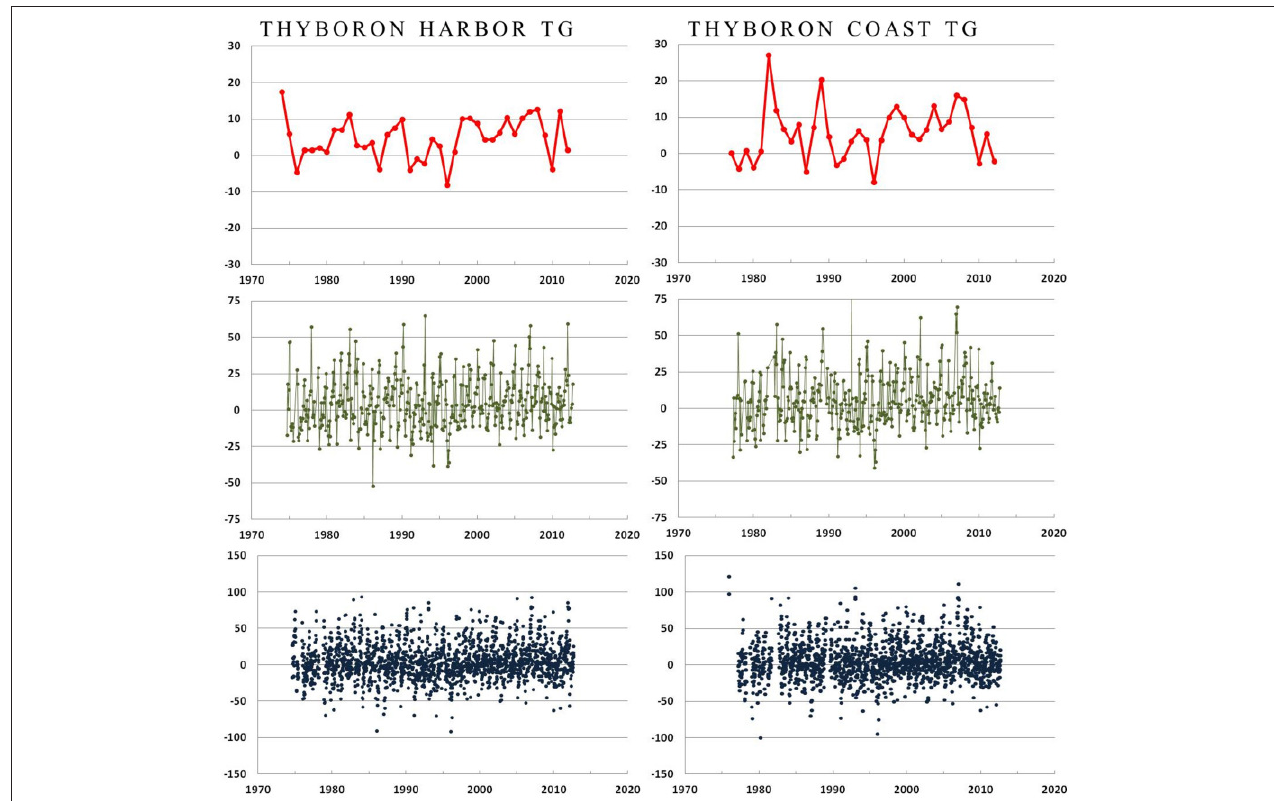
FIGURE 5 | Yearly, monthly, and weekly means (top to bottom) water levels (in cm) at the two Thyboron tide gauges. Discrepancies between the series are mainly due to data quality issues and to local wave setup effects during storms at the coastal TG (Adopted from Sorensen et al., 2015).